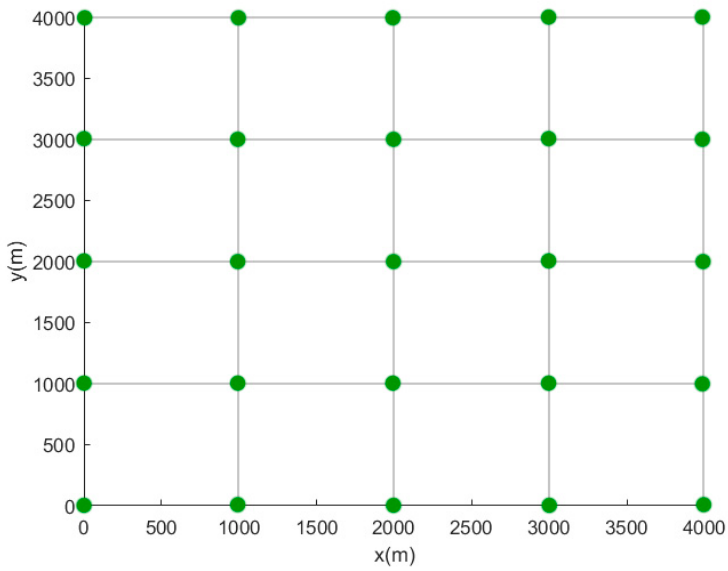
Figure 3. Schematic diagram of establishing coordinate system for the fixed sensor network.